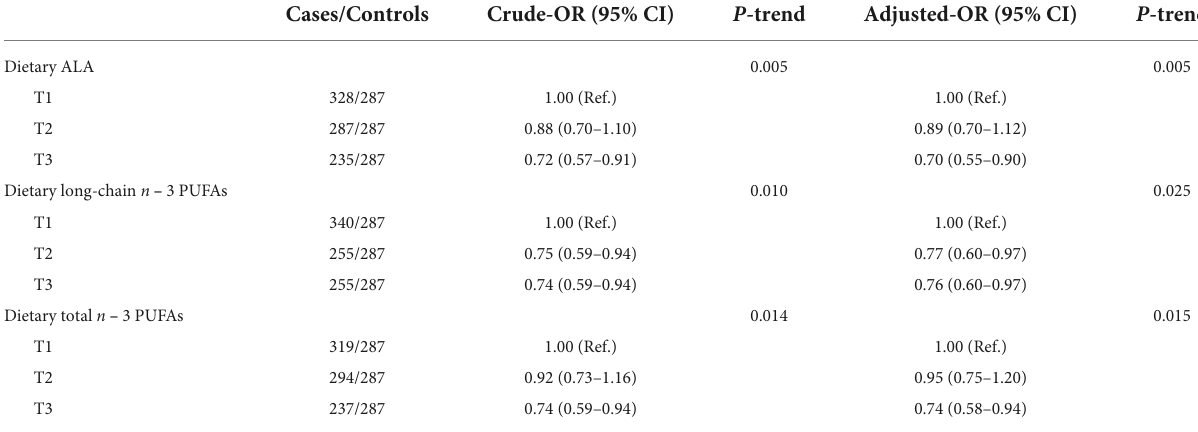
TABLE 2 Associations between dietary n – 3 PUFAs and breast cancer risk a .